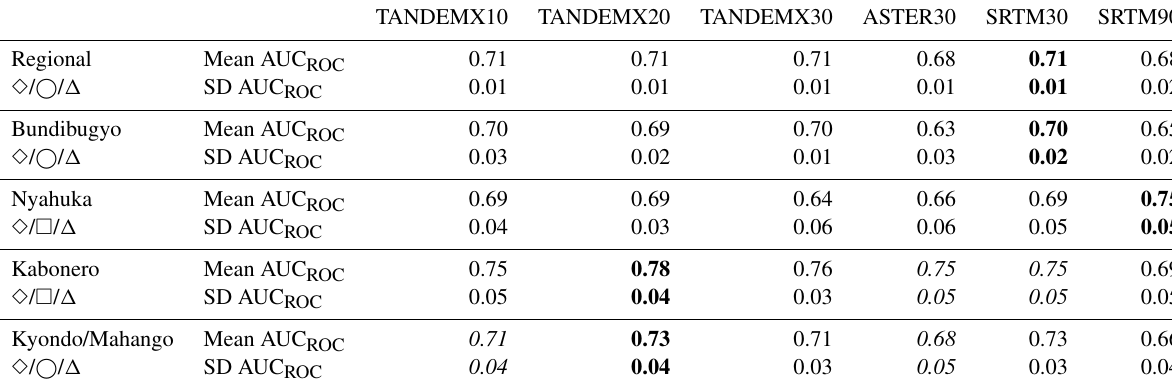
Table 2. Overview of the mean and standard deviation (SD) of AUC ROC over 20 runs for the different model variants at each level. Selected model variants are marked in bold, and values in italic indicate non-normally distributed samples (Shapiro–Wilk test, p< 0 . 05). Wherever applied, all non-parametric tests and the Welch test confirm the results of the parametric tests and results are therefore combined here. Symbols indicate significant differences detected between variants.